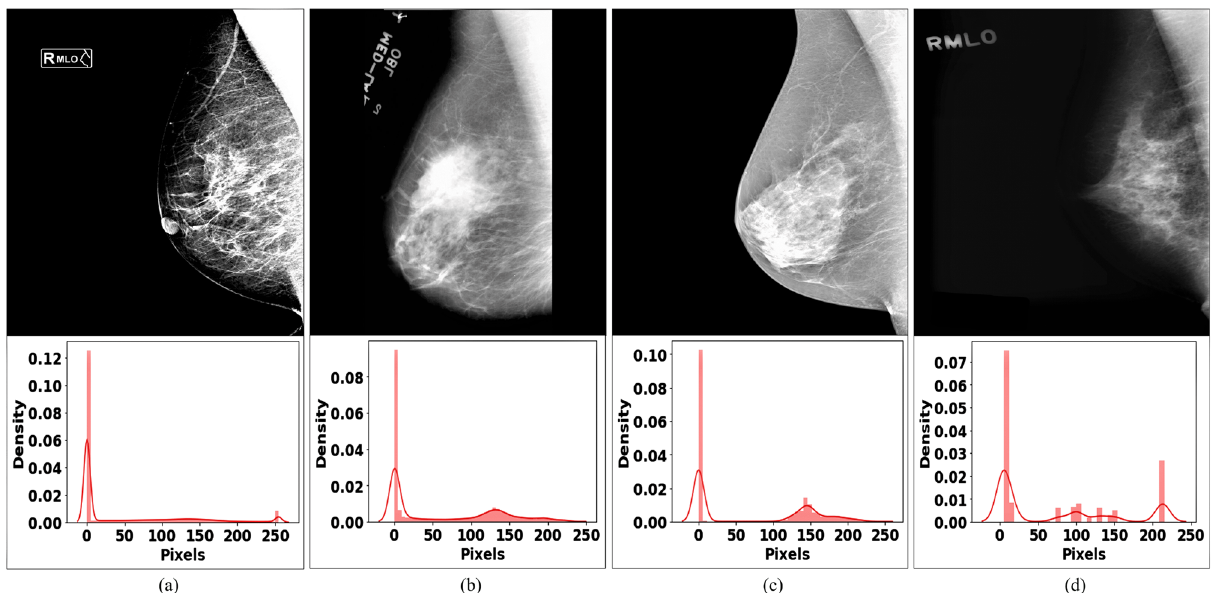
Figure 2. Examples of mammograms from the datasets used in this study. ( a ) KUH, ( b ) MIAS, ( c ) INbreast, and ( d ) mini-DDSM. The histogram of the grayscale value distribution for each mammogram is given below the corresponding